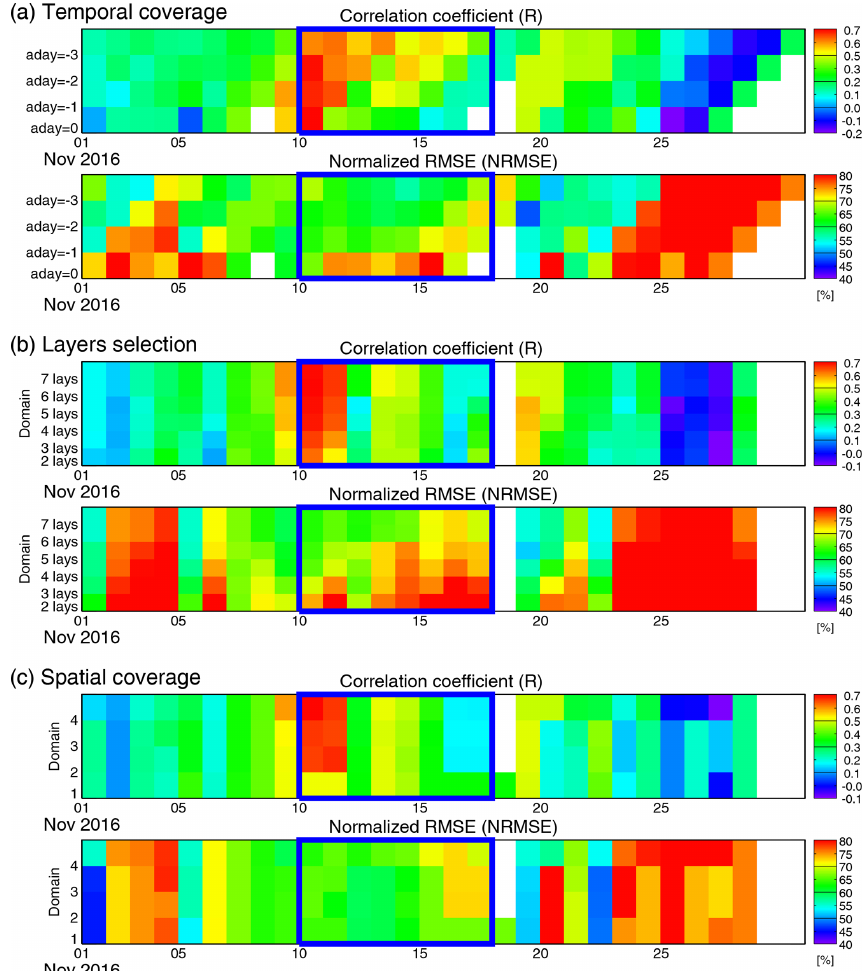
Figure 6. Sensitivity tests for (a) temporal coverage, (b) layer selection, and (c) spatial coverage. Temporal coverage of inputs is tested for between 24h (aday = 0) and 96h (aday =− 3). Selection of layers is tested using two to seven layers among 100, 500, 1000, 1500, 2000, 5000, and 10000m. Beginning from two layers at 100 and 500m, the next higher layer is added for each test. Spatial coverage is tested through domain 1 to 4. The thick blue boxes indicate the intensive fire episode period, 10–17 November